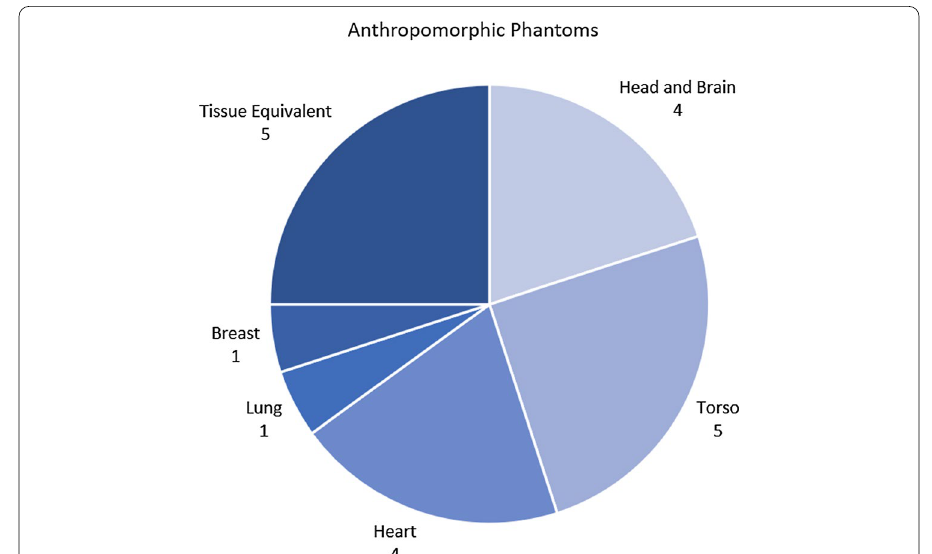
Fig. 4 Anthropomorphic PET/MRI phantoms categorised by the area of human anatomy they